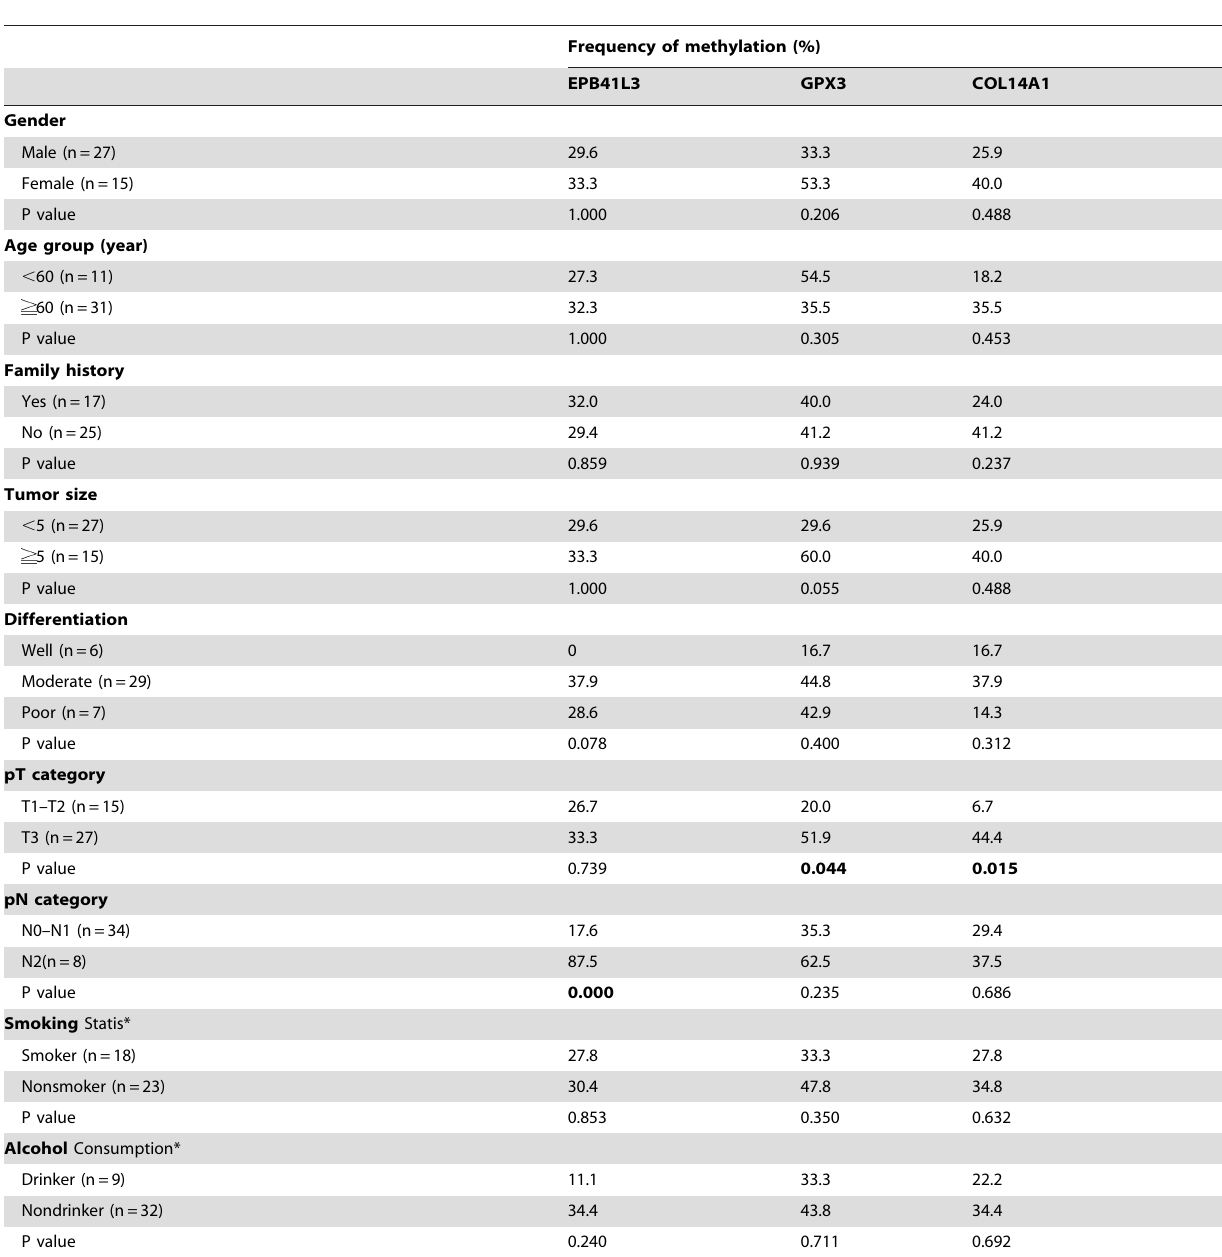
Table 6. Correlation between Blood Plasma DNA Hypermethylation and Clinico- pathological Parameters of Esophageal Squamous Cell Carcinoma Patients (n